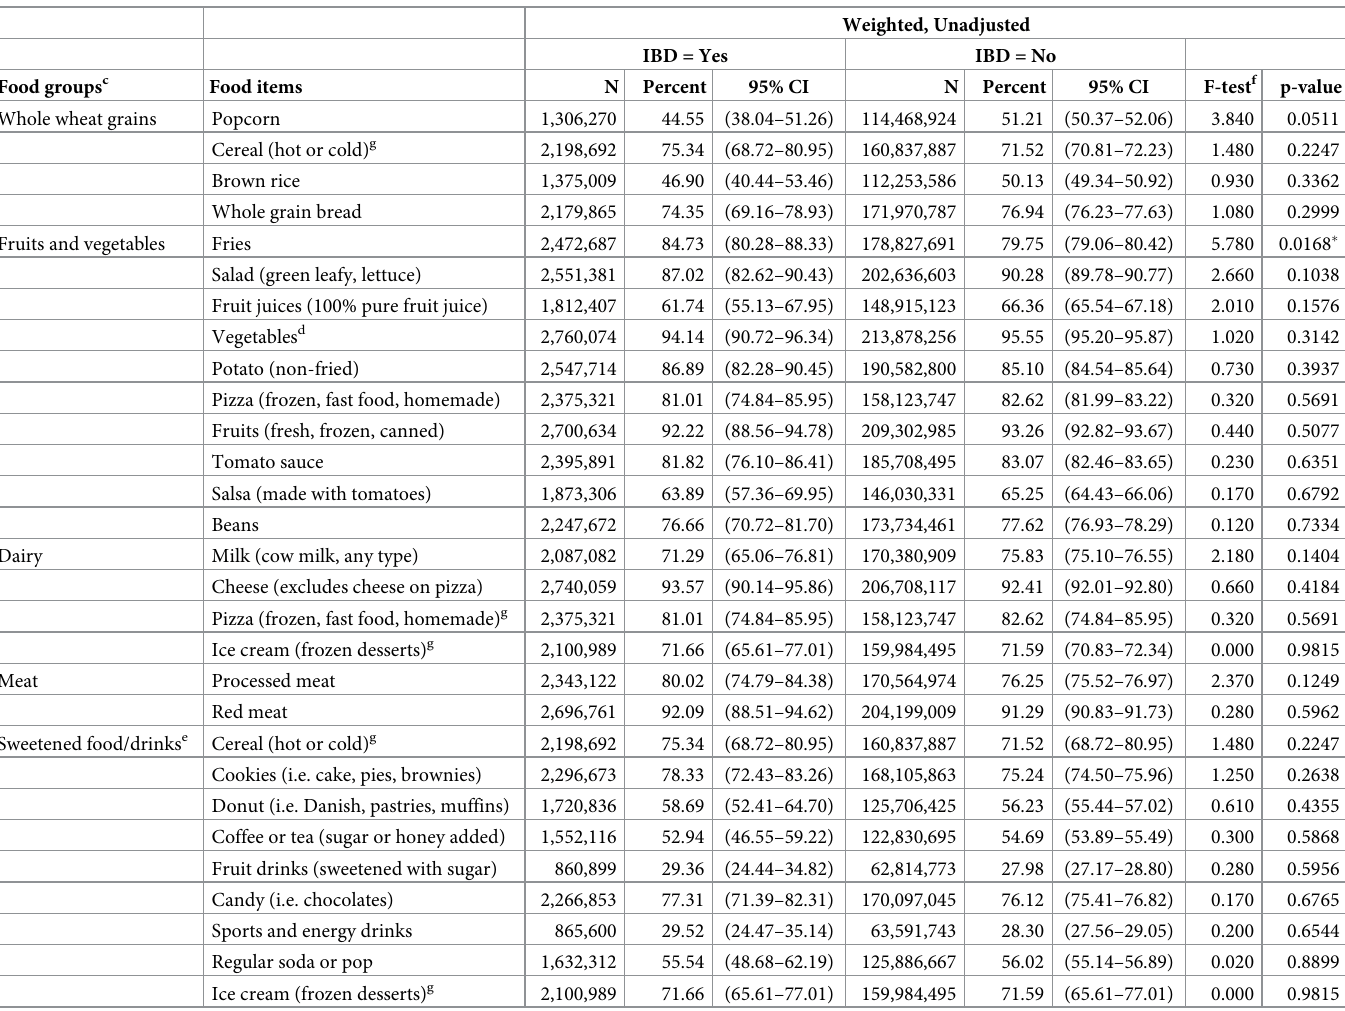
Table 1. Comparison of weighted proportions of food item consumption in IBD and non-IBD estimated US population, NHIS 2015 a,b .